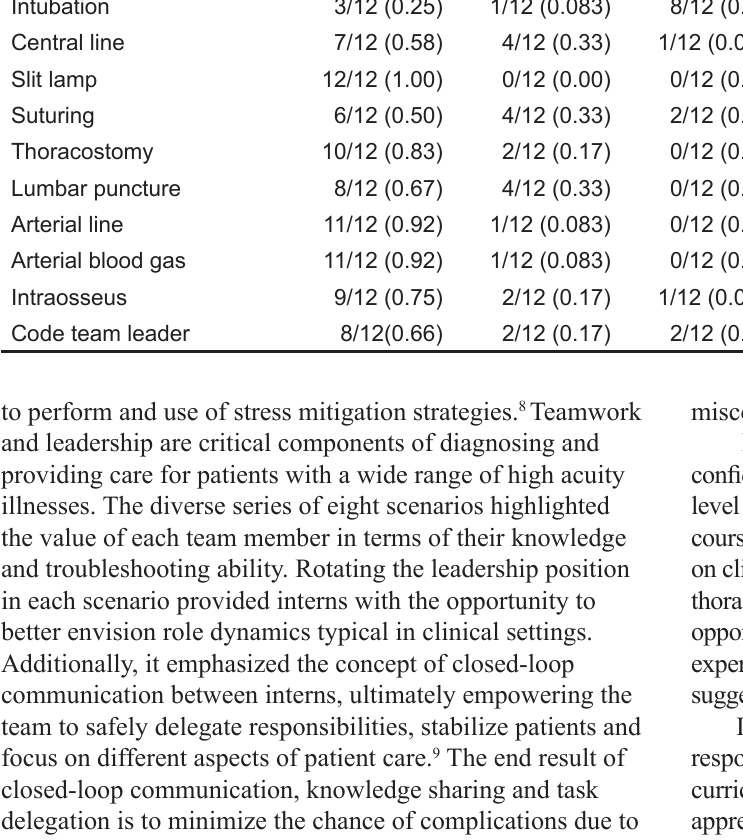
Clinical skills